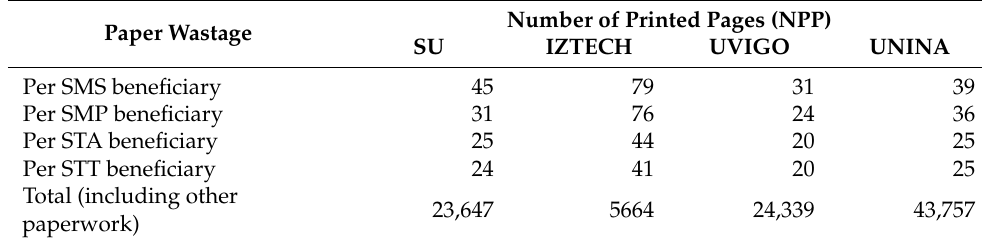
Table 2. Total and per beneficiary amounts of paper.